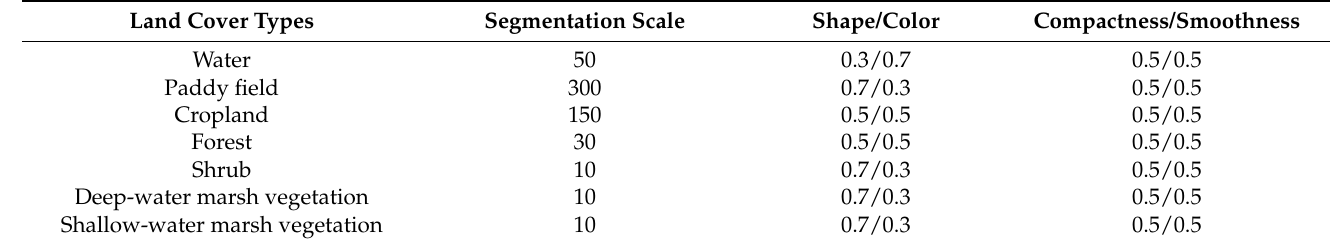
Table 3. Multi-scale segmentation parameters of different land cover types in the study area.